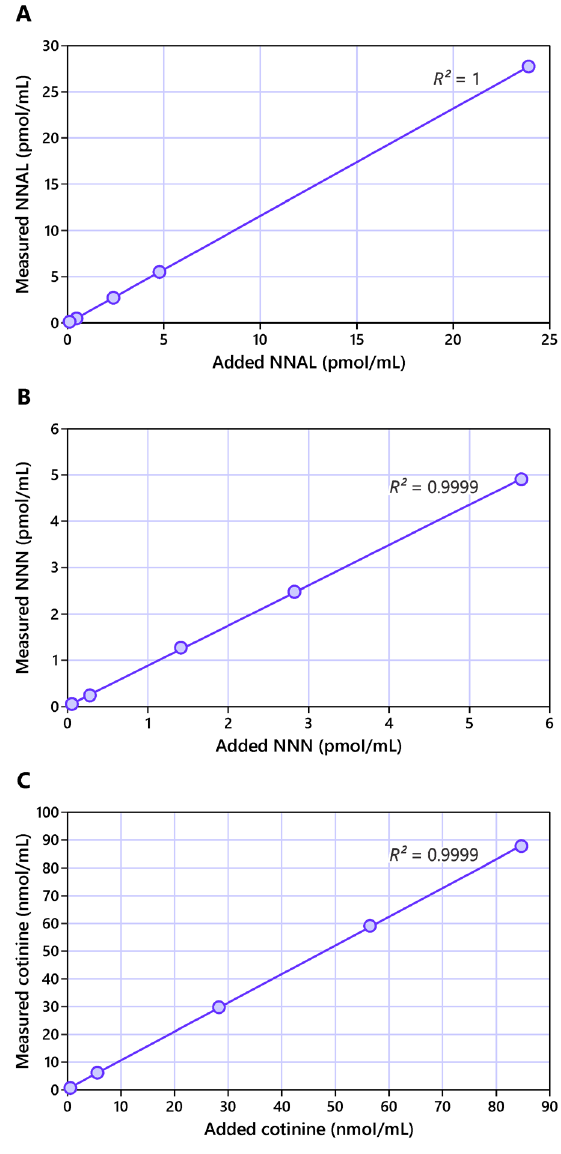
Figure 2. Relationship between added and measured concentrations of ( A ) NNAL, ( B ) NNN, and ( C ) cotinine. The biomarkers were added to a pooled urine from non-users of tobacco. For more detail on method characterization see “Experimental procedures”